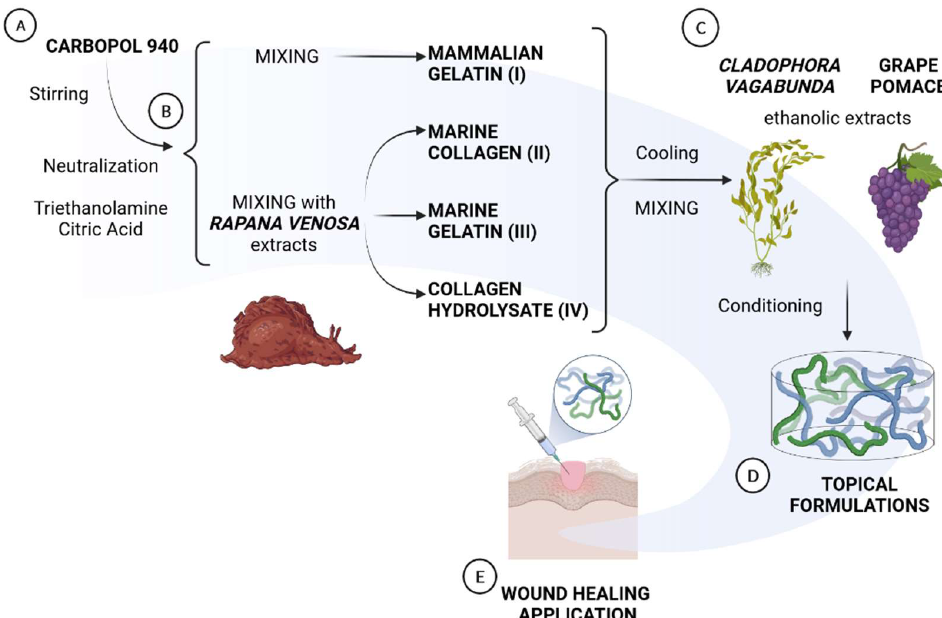
Figure 1. Schematic representation of the sequential steps in the preparation of the four different formulations: A) Carbopol 940 dispersion in water, neutralization and stabilization; B) mixing with mammalian gelatin (Formulation 1) or with Rapana venosa extracts (Formulations II, III and IV); C) combination of the three formulations with Cladophora vagabunda and grape pomace extracts; D) cooling and realization of the final formulations; E) characterization of the formulations. Table 1. Nomenclature and quali-quantitative chemical composition of the different formulations.